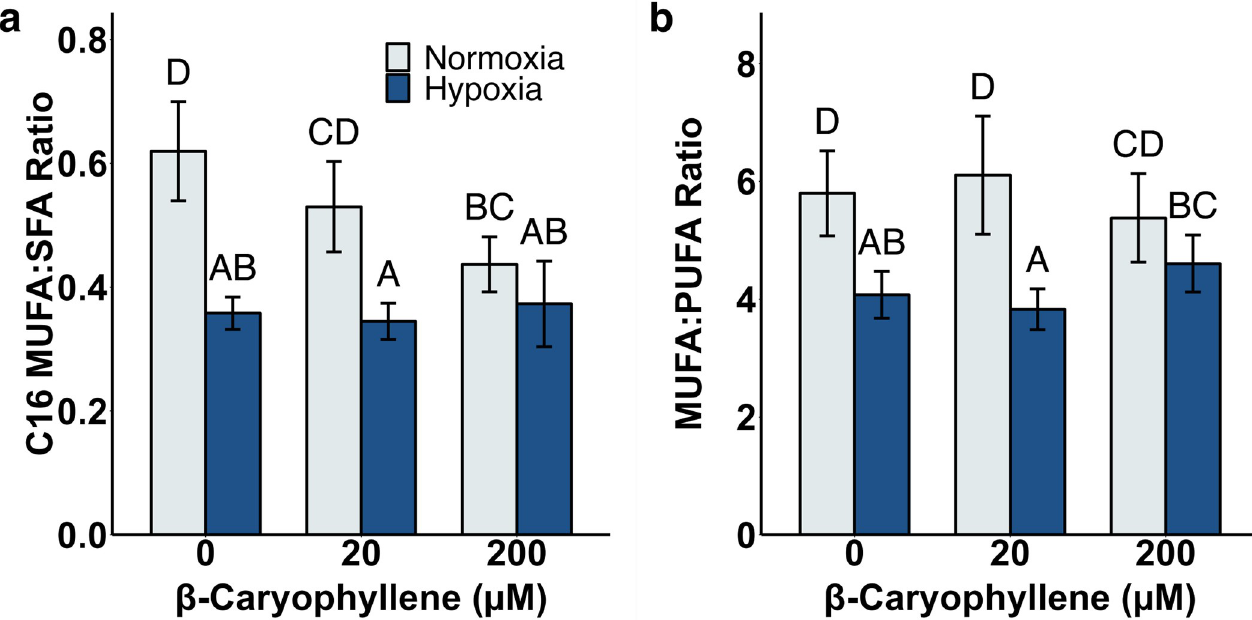
Fig 6. BCP attenuates the effect of hypoxia on fatty acyl saturation ratios. UFH-001 cells were exposed to normoxic or hypoxic conditions in the presence of BCP for 16h. At the end of the incubation, cells were washed and processed for lipid extraction as described in Methods. Bars are means ± S.E.M. of 3 biological replicates. Data were log-transformed for statistical analysis; different letters above the bars indicate statistical differences at α � 0.05. (a) C16 MUFA:SFA [palmitoleic:palmitic] ratio by hypoxia and BCP treatments. (b) MUFA:PUFA ratio by hypoxia and BCP treatments.